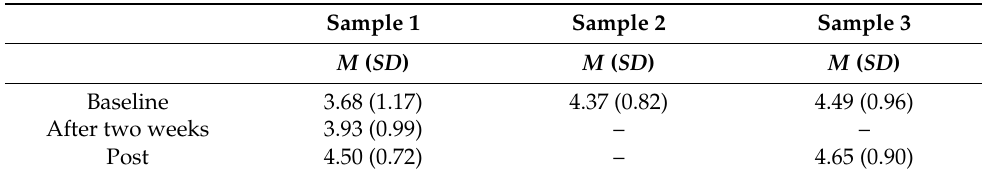
Table 2. Means and standard deviations of the RTW-SE